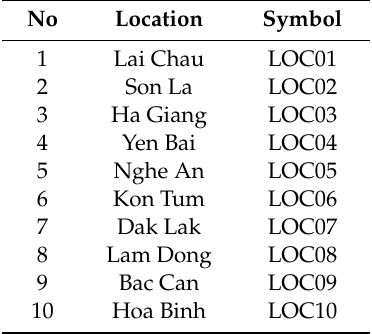
Table 1. Name and symbol of ten location.